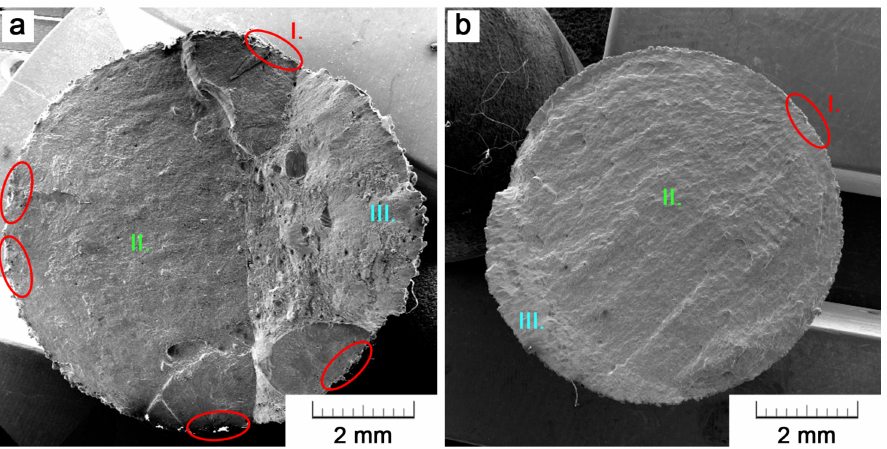
Figure 7. Comparison of fatigue fracture surfaces of ( a ) EBM and ( b ) SLM specimen. Areas I. (in red) represent initiation sites, II. represent areas of fracture propagation (in green) and III. is the final fracture area (in